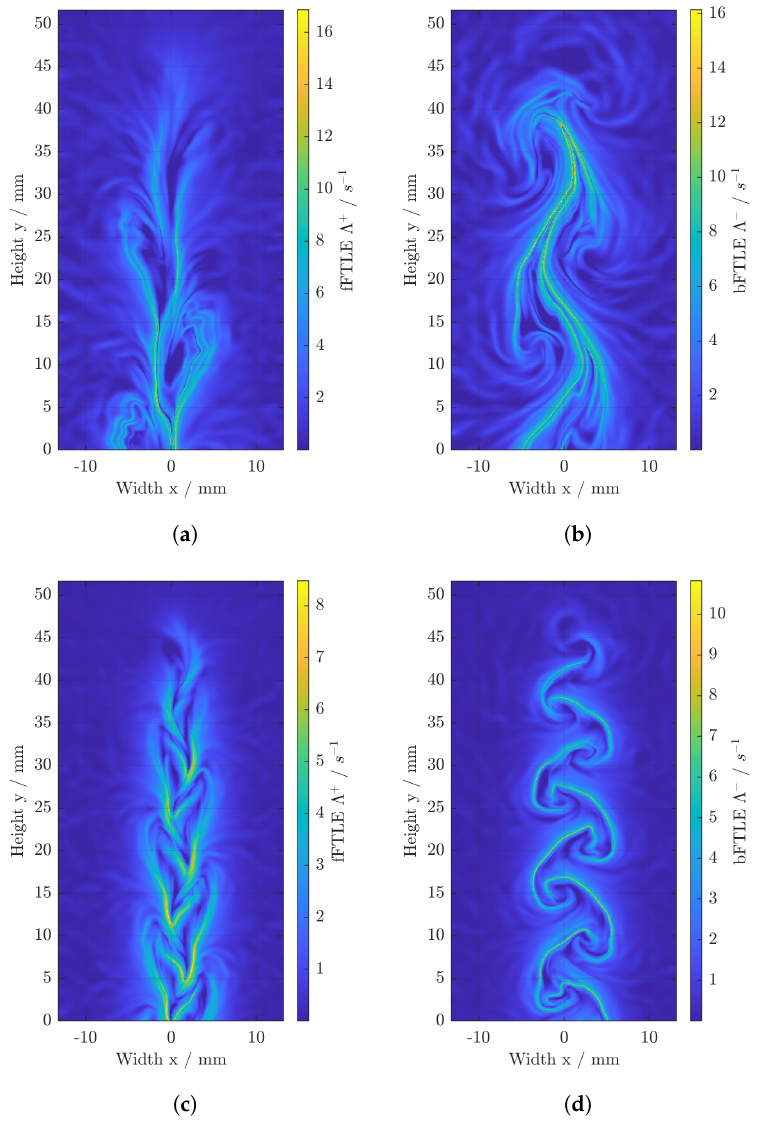
Figure 5. FTLE fields for the entire finite-time intervals studied. ( a ) fFTLE wobbling bubble τ ∈ [0 s, 0.408 s], ( b ) bFTLE wobbling bubble τ ∈ [0.408 s, 0 s], ( c ) fFTLE ellipsoidal bubble τ ∈ [0 s, 0.524 s] and ( d ) bFTLE ellipsoidal bubble τ ∈ [0.524 s, 0